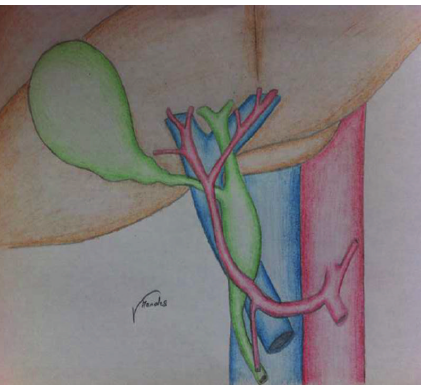
Figure 4: Schematic diagram illustrating the compression on the CBD exerted by the anterior aberrant